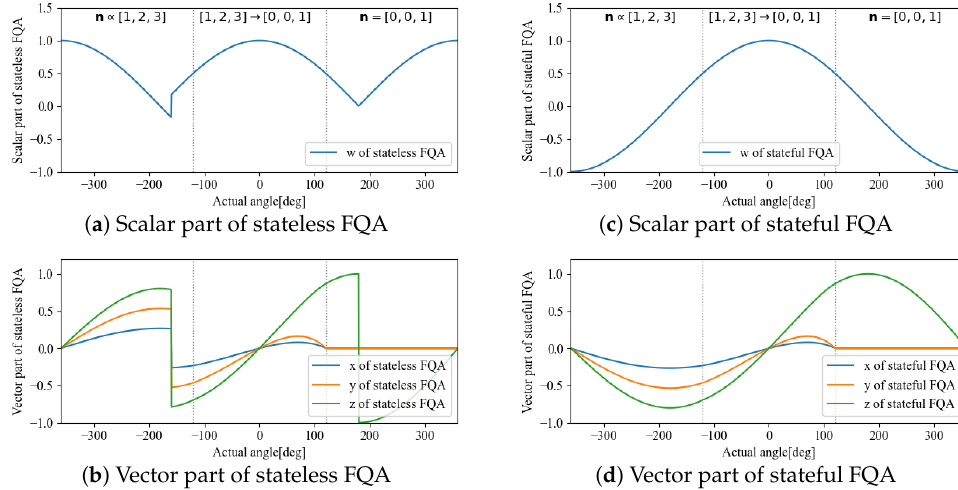
Figure 8. Comparison between stateless FQA ( left ) and stateful FQA ( right ).